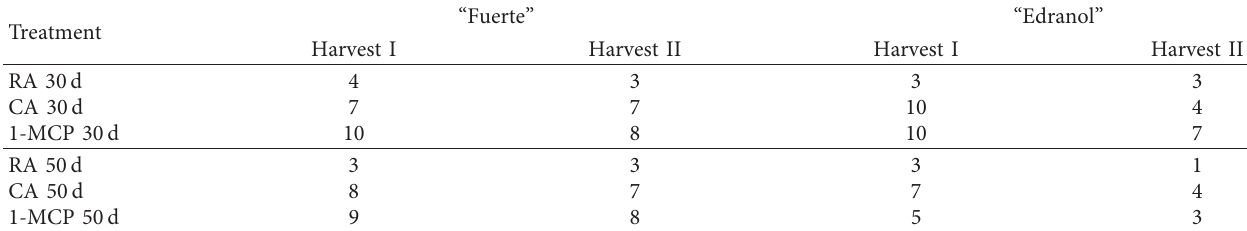
Table 6: Days required for reaching a ready-to-eat stage during shelf life at 20 ° C, after each storage period at 5 ° C.